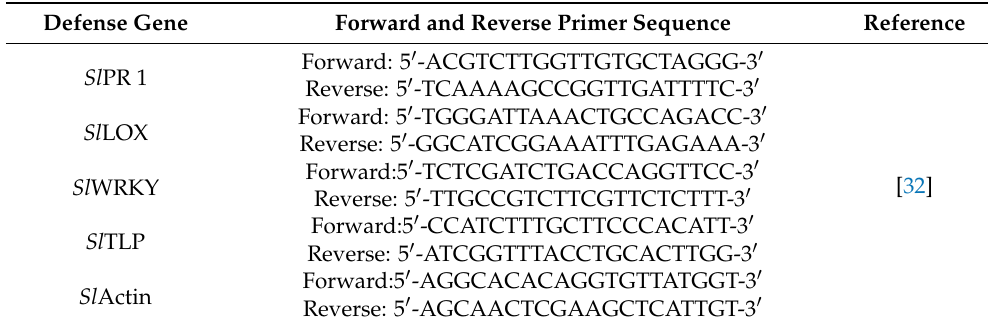
Table 2. Defense gene primers used for quantitative